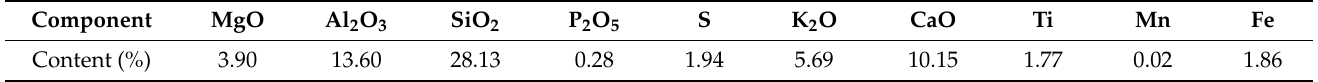
Table 1. Determining the composition of the CTF by XRF analysis method (% by